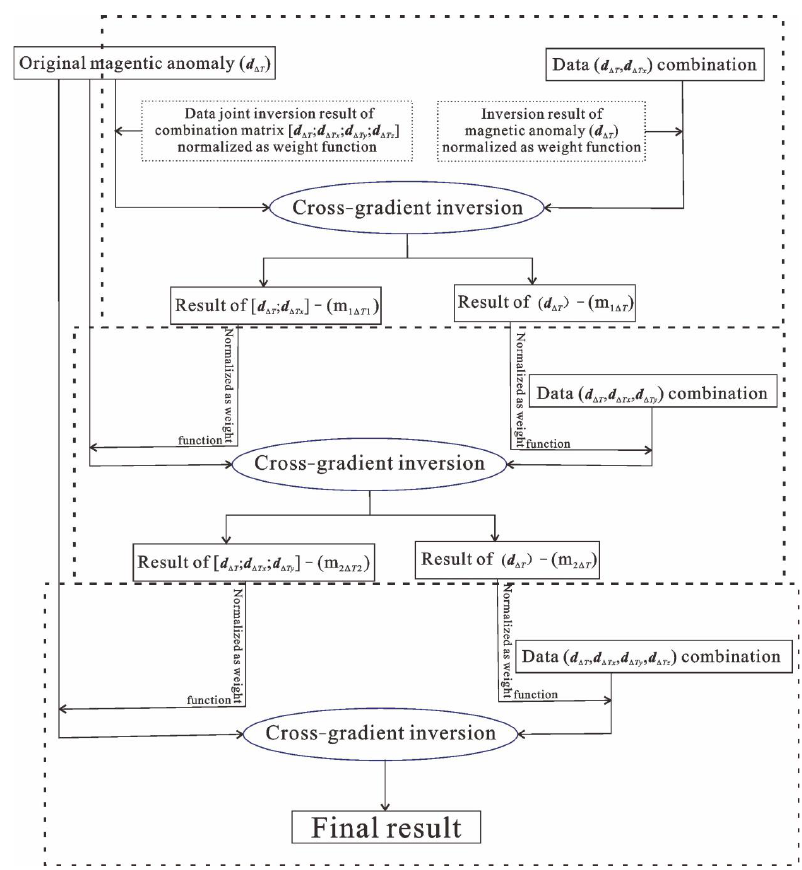
Figure 4. Flowchart of the ICW method.